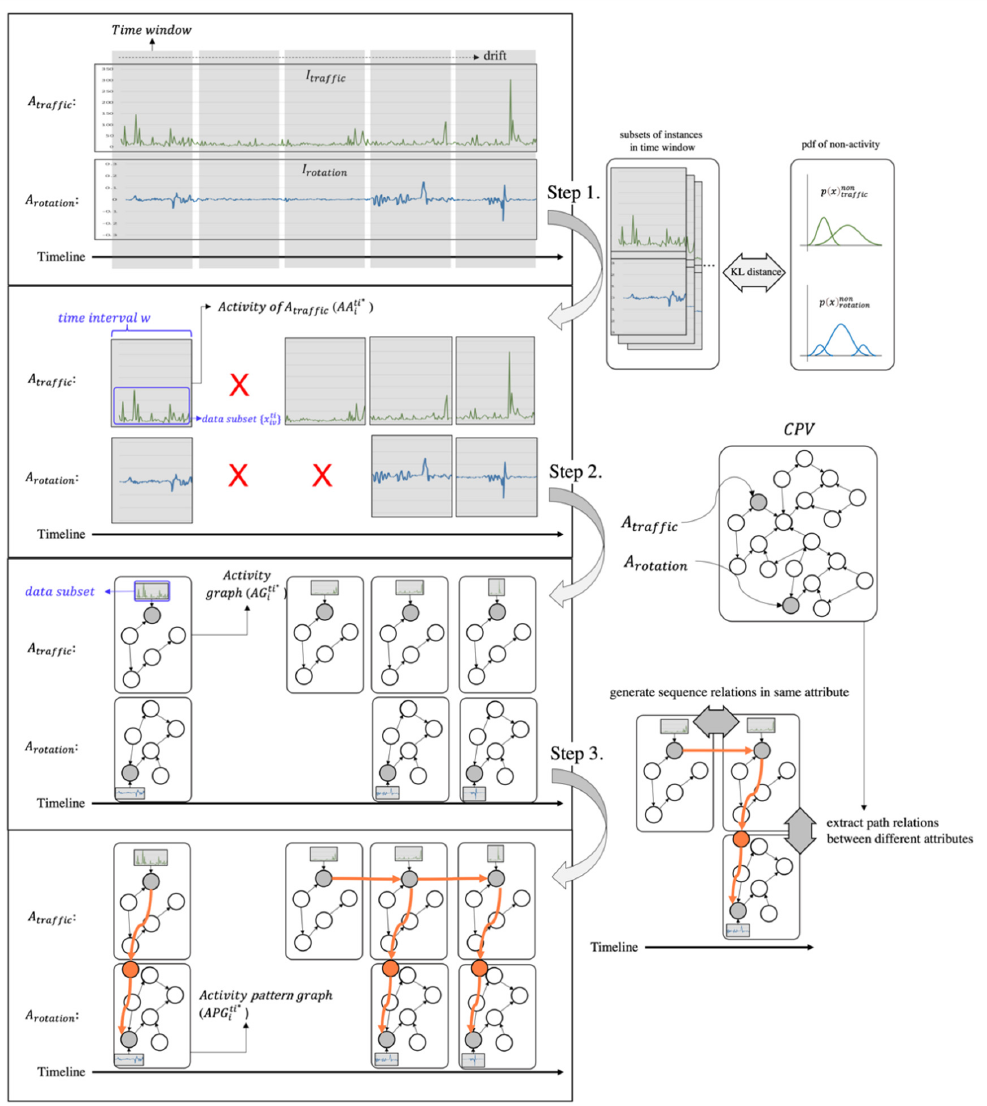
Figure 5. The generation procedure of activity patterns graphs.